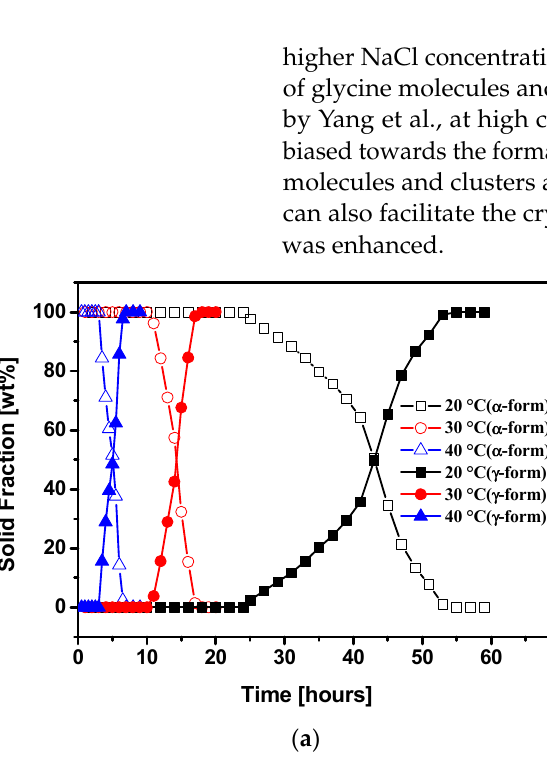
Figure 5. Influence of crystallization temperature on glycine polymorphic phase transformation of glycine α -form to γ -form. ( a ) Solid fraction of γ -form and α -form glycine; ( b ) glycine solution concentration during crystallization. The agitation speed, NaCl concentration, and seed concentration were fixed at 750 rpm, 80 g/L, and 60 g/L, respectively.